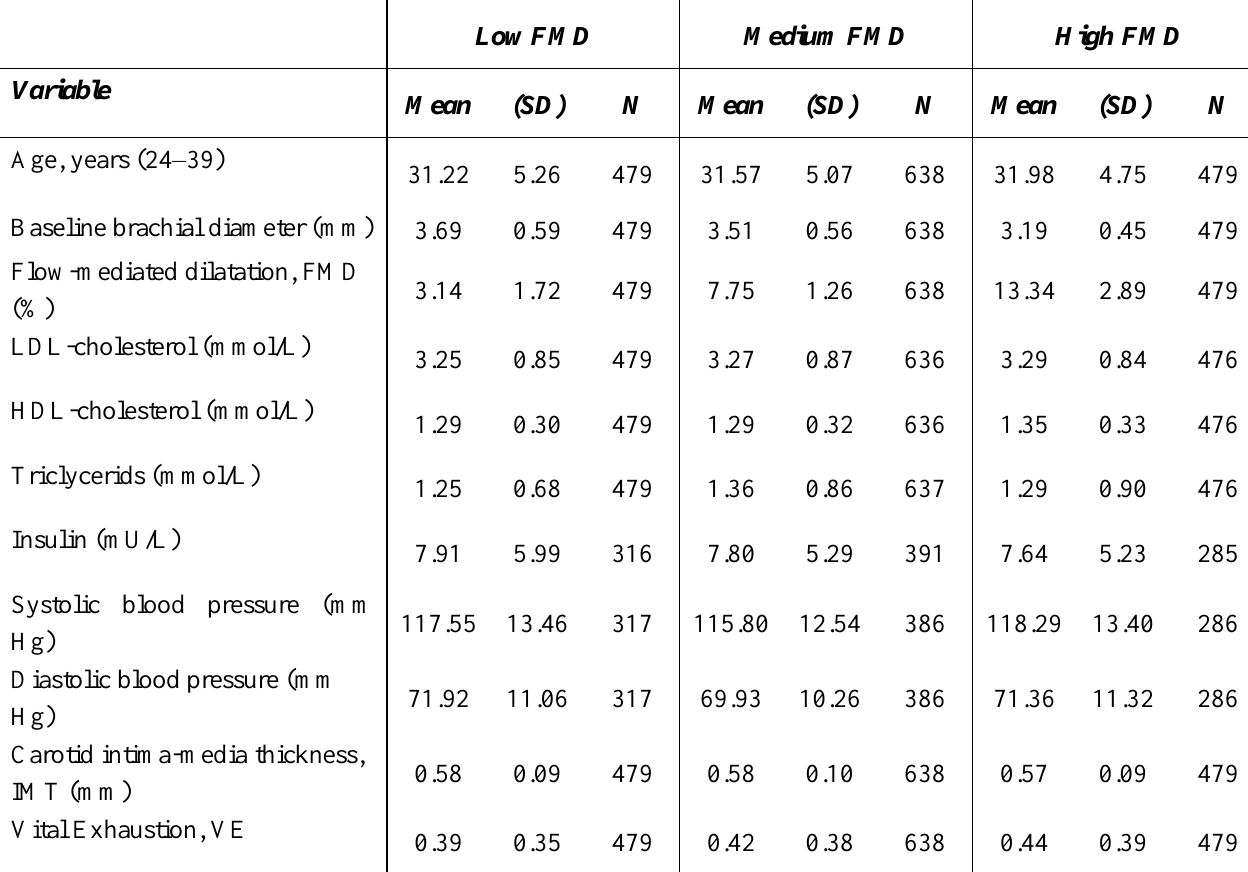
Table 2. Study characteristics in subgroups stratified by FMD